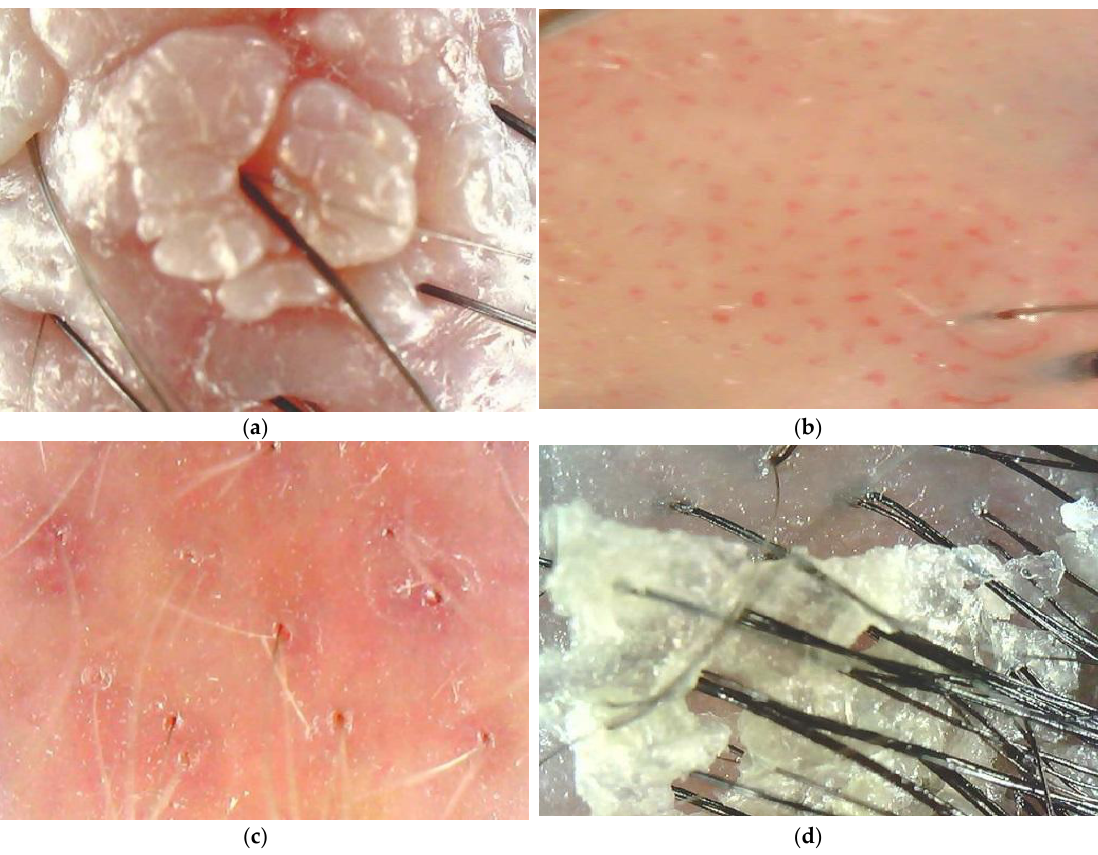
Figure 20. ( a ) Bacteria type 1 image; ( b ) bacteria type 2 image; ( c ) allergy image; ( d ) dandruff image.